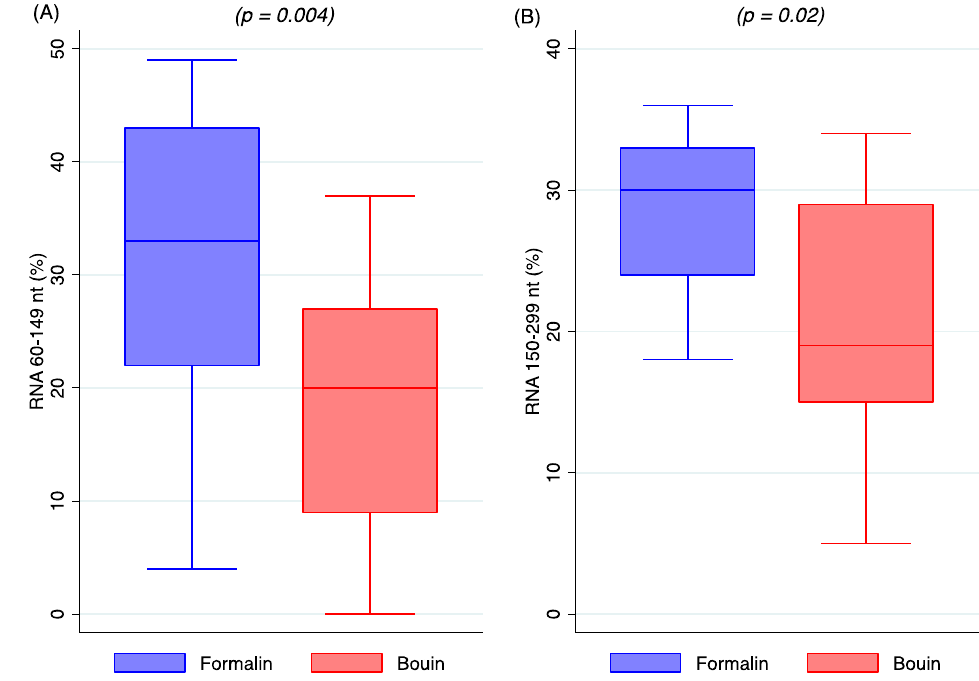
Figure A1. Box plot representing the relative amount of RNA stretches of ( A ) 60–149 nucleotides and ( B ) 150–299 nucleotides in matched formalin- and Bouin’s solution-fixed samples. The box represents the first and third quartiles, intersected by the median, and the whiskers are the range.